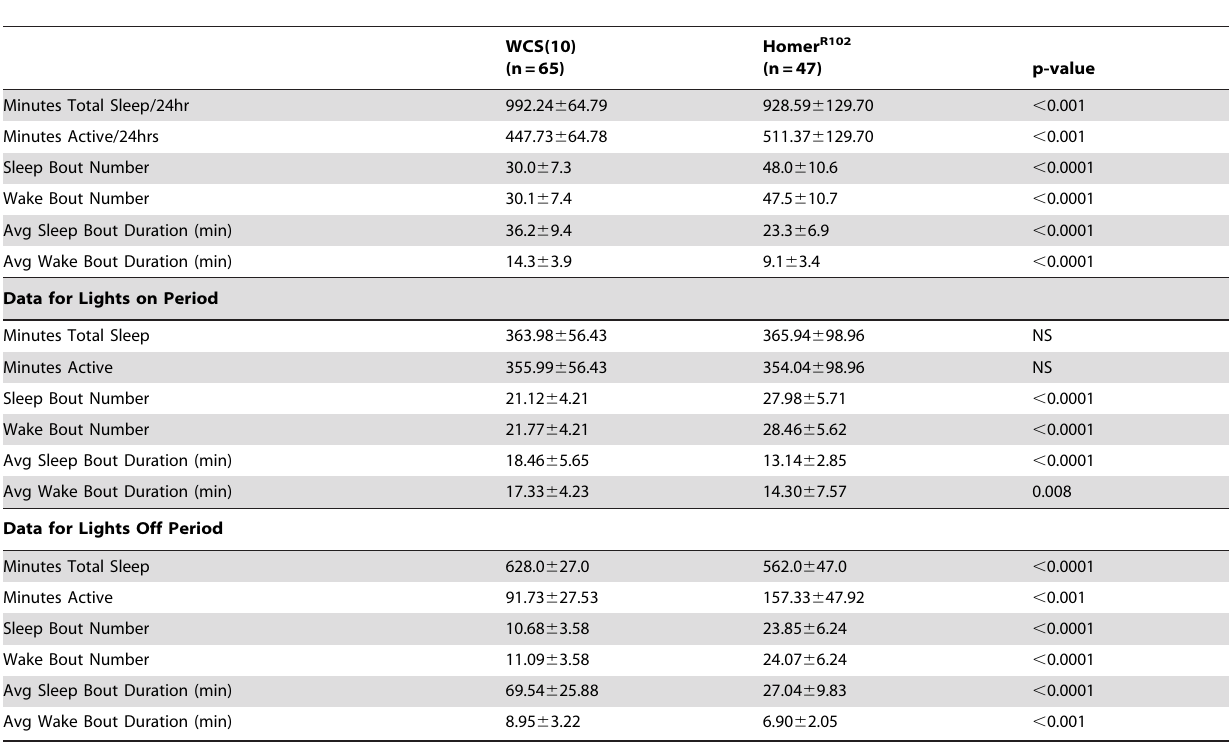
Table 1. Sleep-wake data from homer null and WCS(10) flies over 24 hr and during the day and night using video analysis.